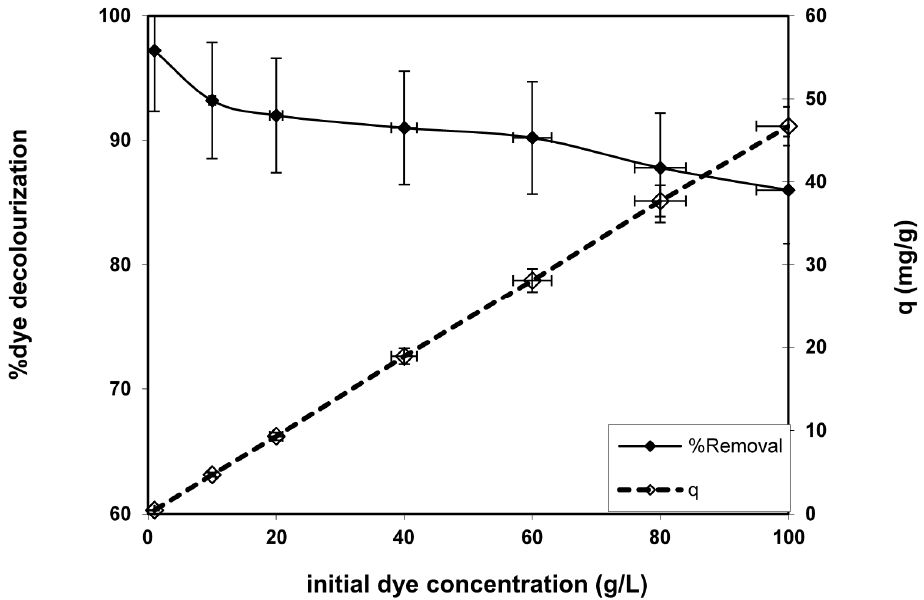
Figure 4. Effect of initial dye concentration on dye removal capacity and percentage decolorization onto the chemically modified nanofiber. (Volume of dye solution = 50 mL, agitation speed = 400 rpm, dosage of nanofiber = 0.1 g, pH = 6.2 and temperature = 25 °C).